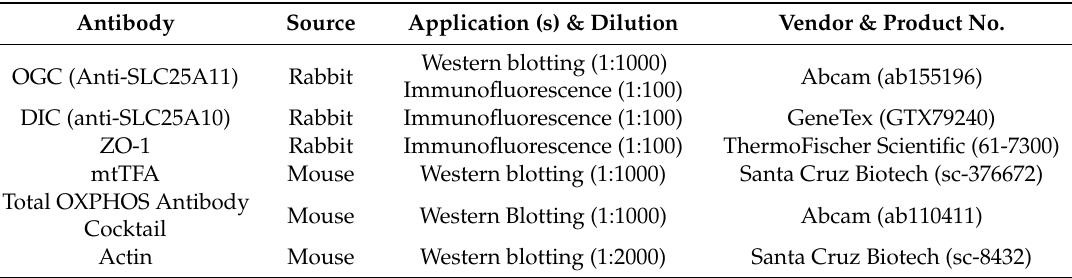
Table 1. List of antibodies